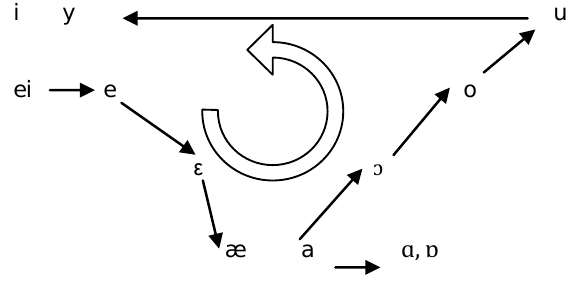
Figure 1: The Portuguese Vowel Shift (viz. Rogers 1940, 1948; Martinet